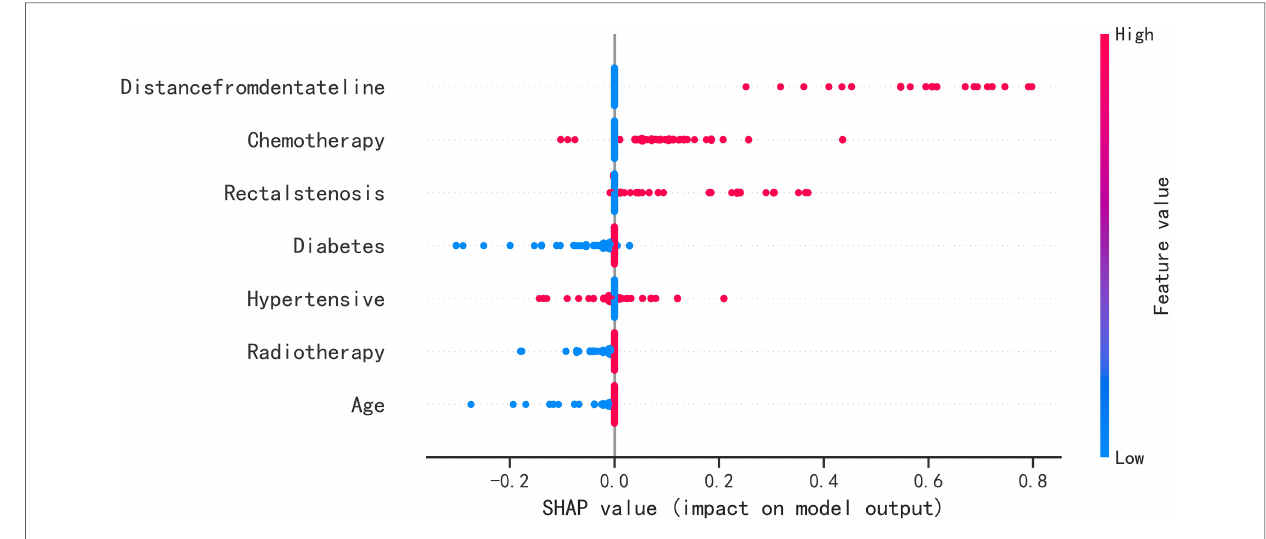
FIGURE 4 SHAP summary plot. Risk factors are arranged along the y-axis based on their importance, which is given by the mean of their absolute Shapley values. The higher the risk factor is positioned in the plot, the more important it is for the